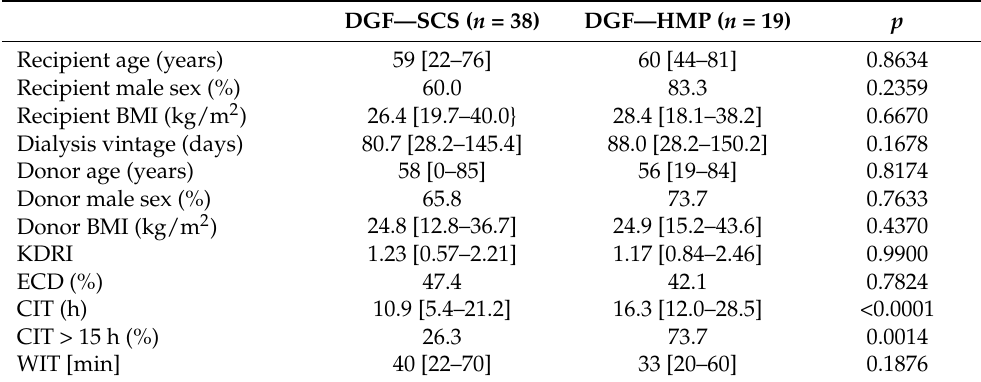
Table 5. Recipient, donor and surgical details with regards to the preservation